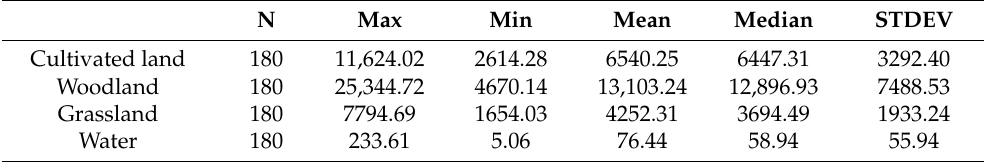
Table 2. Descriptive statistic of variables.